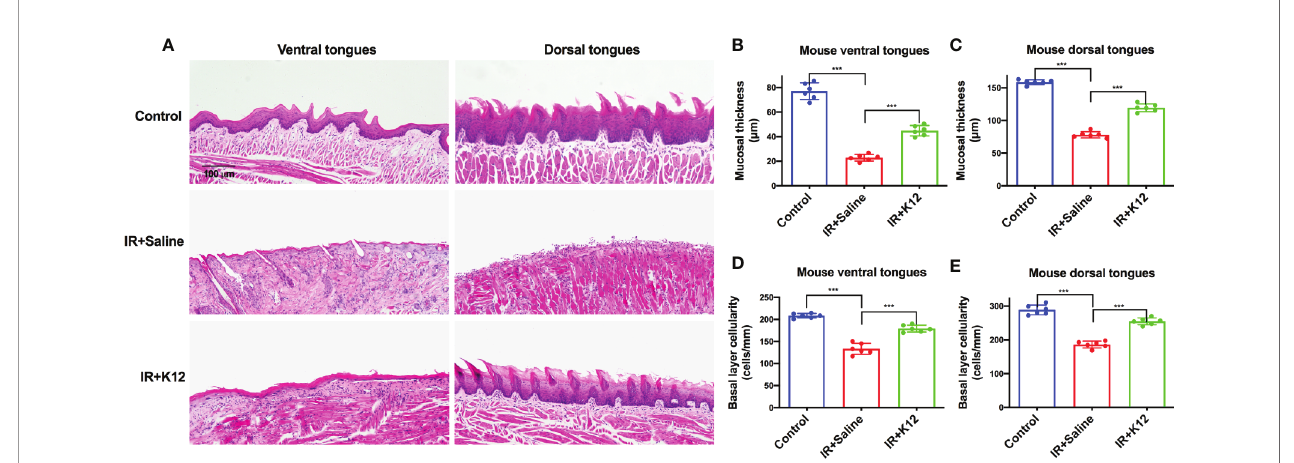
FIGURE 2 | Streptococcus salivarius K12 promotes RIOM healing in mice. (A) Representative images of H&E staining indicating the integrity of lingual mucosa (Scale bar, 100 µm). (B, C) Quantitative analysis of mucosal thickness of ventral tongues and dorsal tongues, respectively. (D, E) Basal layer epithelial cellularity of ventral tongues and dorsal tongues, respectively. Data are presented as mean ± SD. N=6 per group. One-way ANOVA test followed by Tukey ’ s test. *** P